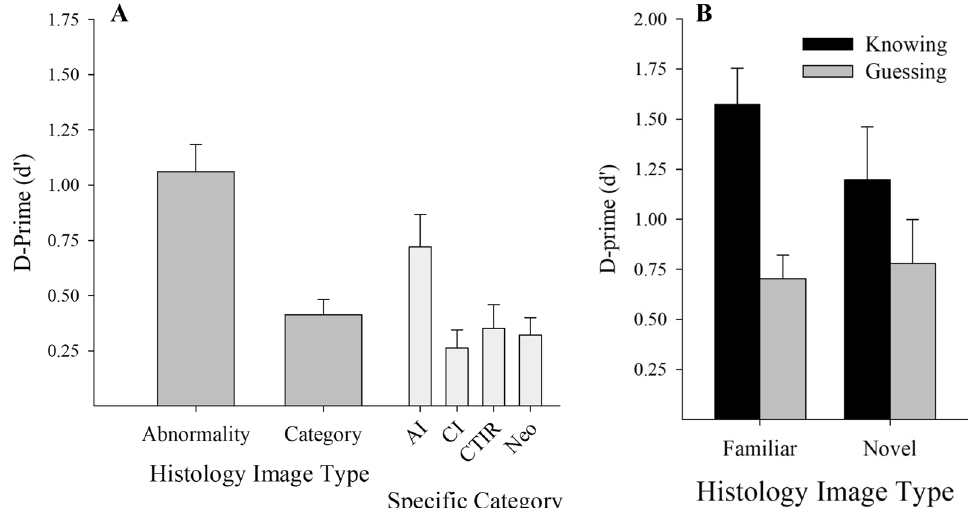
Fig. 4 a Naïve participants’ ability following perceptual learning i abnormality detection (left) and in category identification (right). b Naïve participants’ abnormality detection ability with novel and familiar histology images, computed separately for self-reported guessing versus